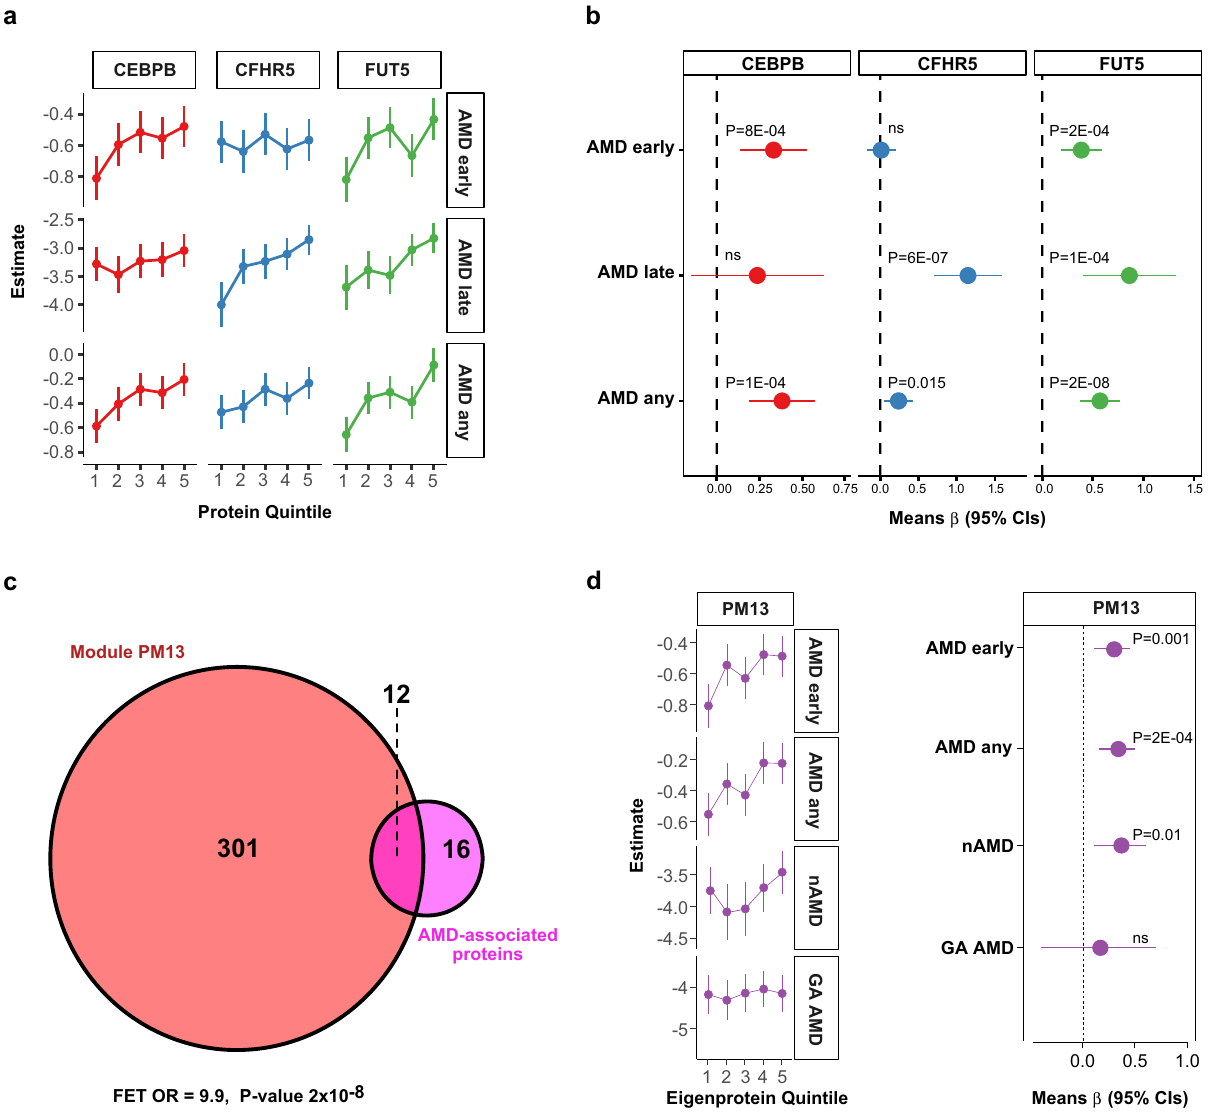
Fig. 2 Serum proteins are linked to different stages of AMD. a Relationship between quintiles of serum CEBPB, CFHR5, and FUT5 levels and AMD outcomes, whereas b highlights the comparison of the top and bottom quintiles of the same proteins to different AMD outcomes. c Venn diagram demonstrating signi fi cant enrichment for 12 of the 28 AMD-associated proteins (OR = 9.89, P = 2.1 × 10 − 8 , two-sided) in the previously described serum protein network module called PM13 11 . FET is an abbreviation for Fisher exact test. d The Eigenprotein for PM13 was found to be associated with AMD- related outcomes such as nAMD but not GA AMD. De fi nition of early-stage AMD in a , b , d was according to Holliday et al. 22 and the number of patients in each AMD-related group is shown in Supplementary Data 1. The dependent variable is the AMD outcome, while the protein quintiles are predictor variables, and the logistic regression analysis was adjusted for age and sex. The data points in a , d (left panel) represent the predicted mean log odds of the AMD event with the quintiles treated as categorical variables, and the error bars represent 95% con fi dence intervals (CIs). The data points in b , d (right panel) are the mean estimate of beta in the logistic regression (logOR) using quintiles as continuous predictor variable and the error bars represent 95% CIs. All highlighted P -values are two-sided. NS denotes not signi fi cant ( P >